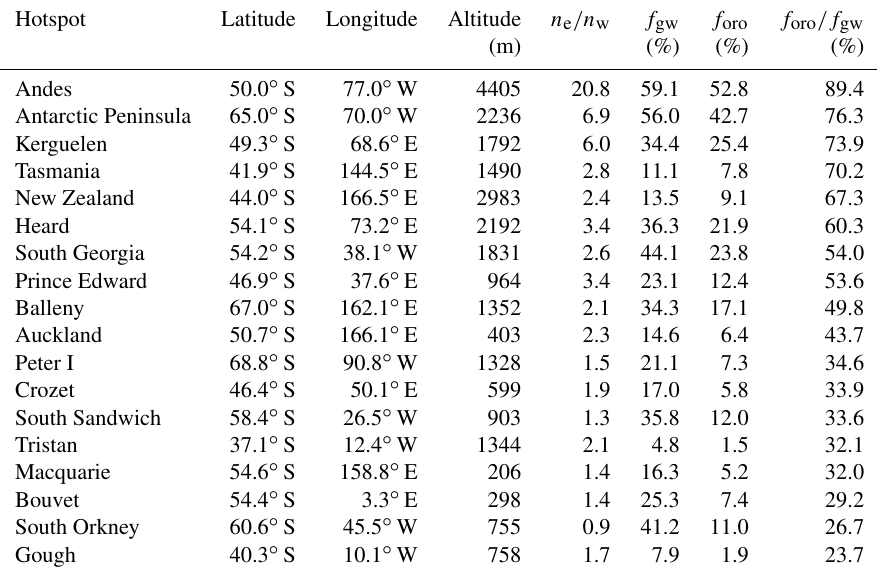
Table 1. Southern Hemisphere orographic hotspots of stratospheric gravity wave activity. In this table n e /n w refers to the ratio of events with gravity wave variances in the eastern box being larger than in the western box, f gw to the gravity wave occurrence frequency, and f oro to the orographic wave occurrence frequency as observed by AIRS. The table is ordered by the ratio f oro /f gw